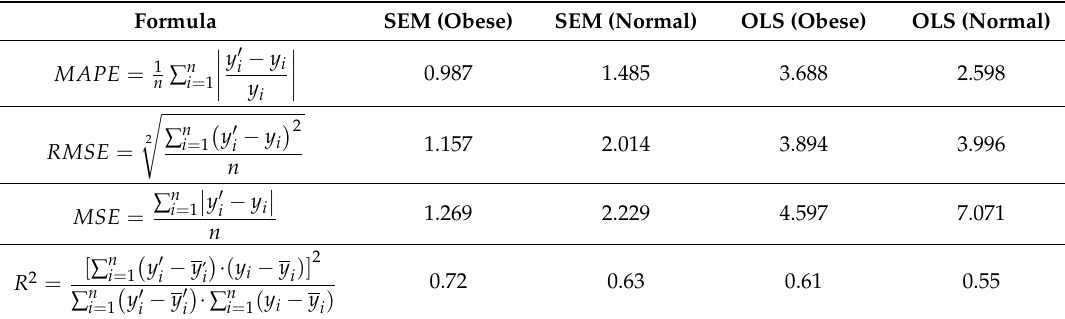
Table 9. Comparative outputs of SEM and OLS in obesity and normal